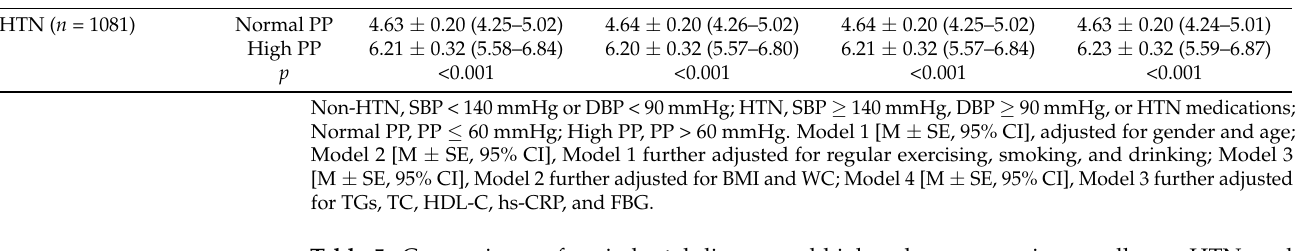
Table 5. Comparisons of periodontal disease and high pulse pressure in overall, non-HTN, and HTN